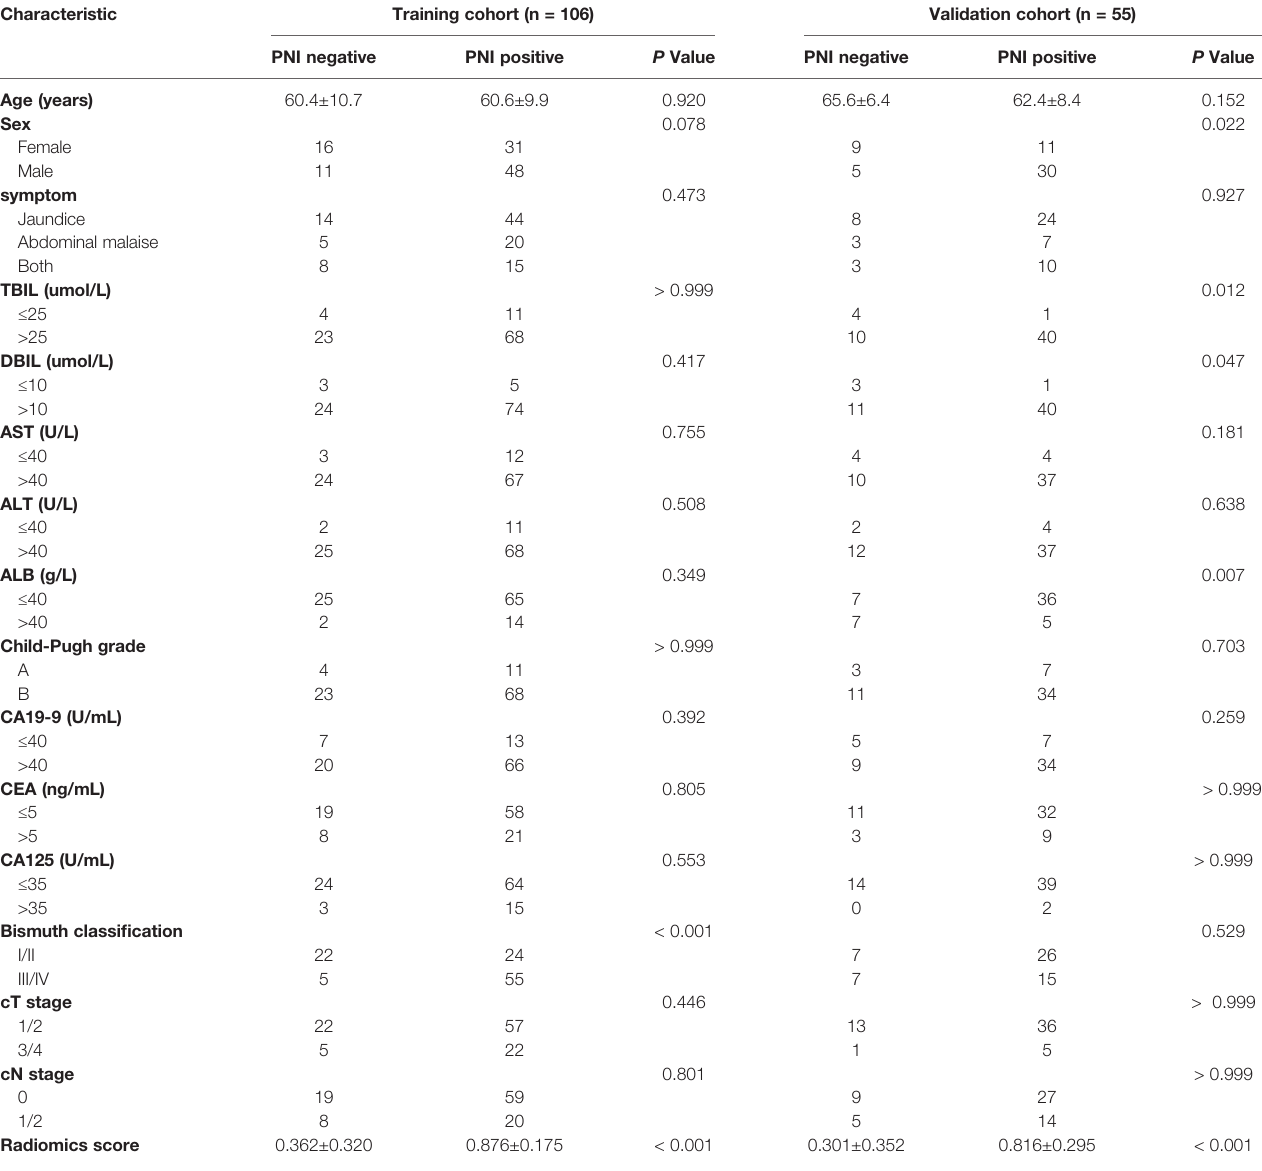
TABLE 1 | Characteristics of patients in the training and validation cohort.